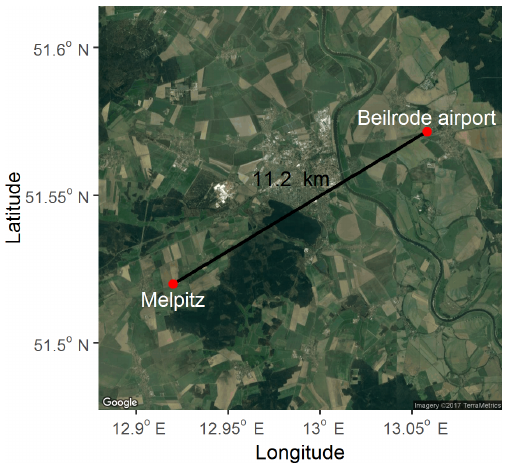
Figure 2. Location of the measurement sites Melpitz and the airfield in Beilrode. Map from